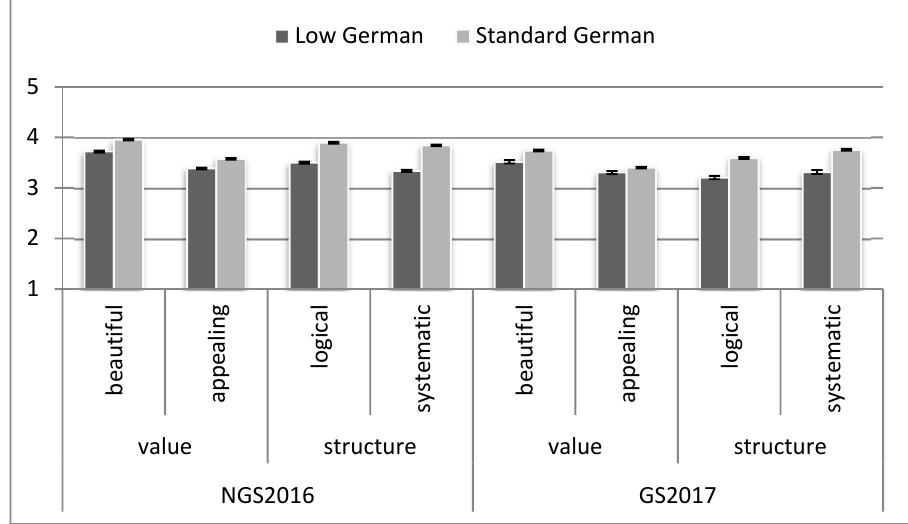
Figure 6. Evaluations of Low German and Standard German (AToL scale, NGS2016 and GS2017).